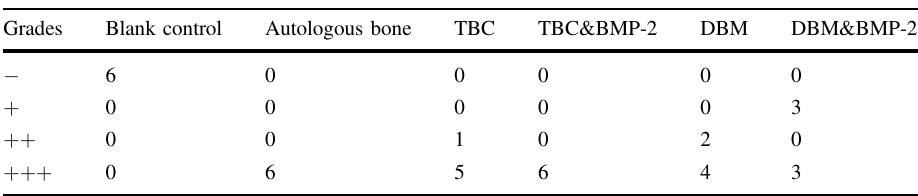
Table 3 Hitchcock grades count of radial